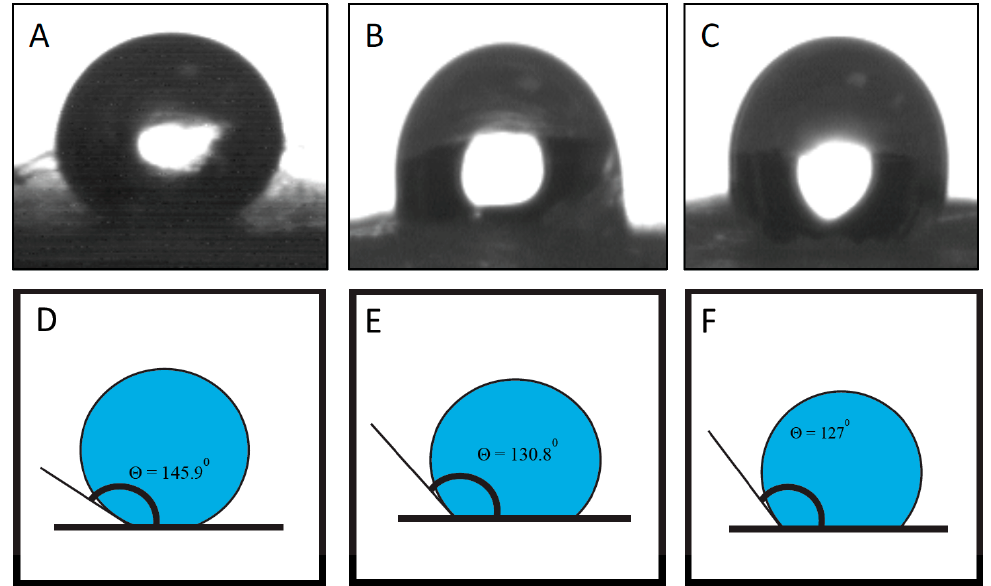
Figure 3. Contact angle for random-oriented PCL mats and PCL mats loaded with HNTs. ( A ) Pure PCL (145.9°); ( B ) PCL with 5% HNT (130.8°); and ( C ) PCL with 10% HNT (127 °). n = 6. ( D – F) graphically illustrated contact angles shown in ( A – C) .